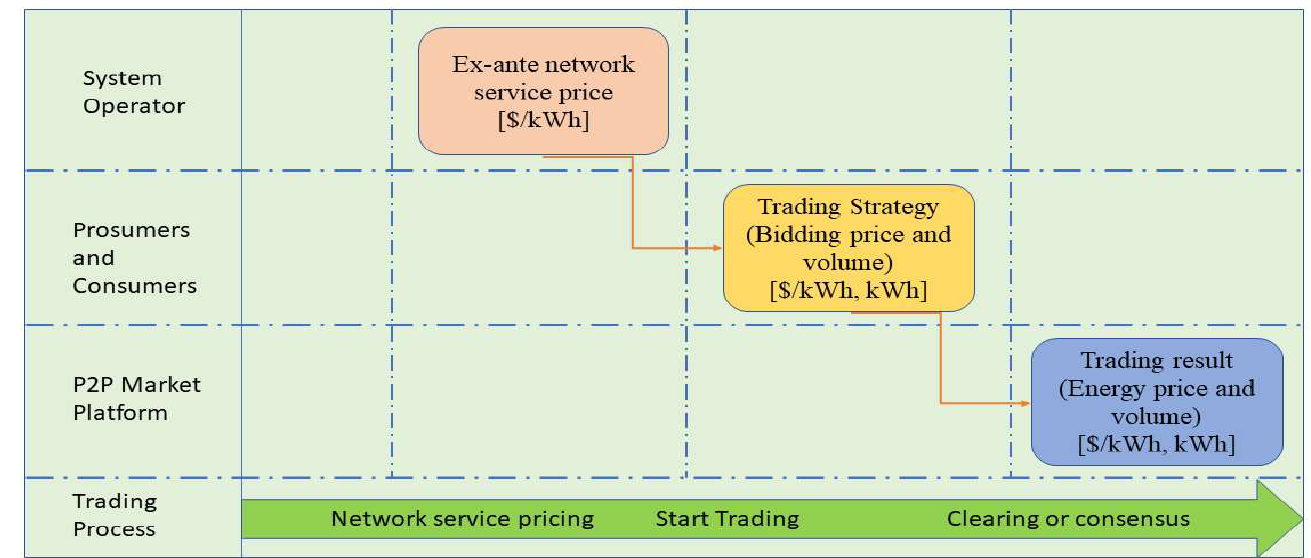
Figure 8. P2P energy trading process based on the ex-ante network service pricing .